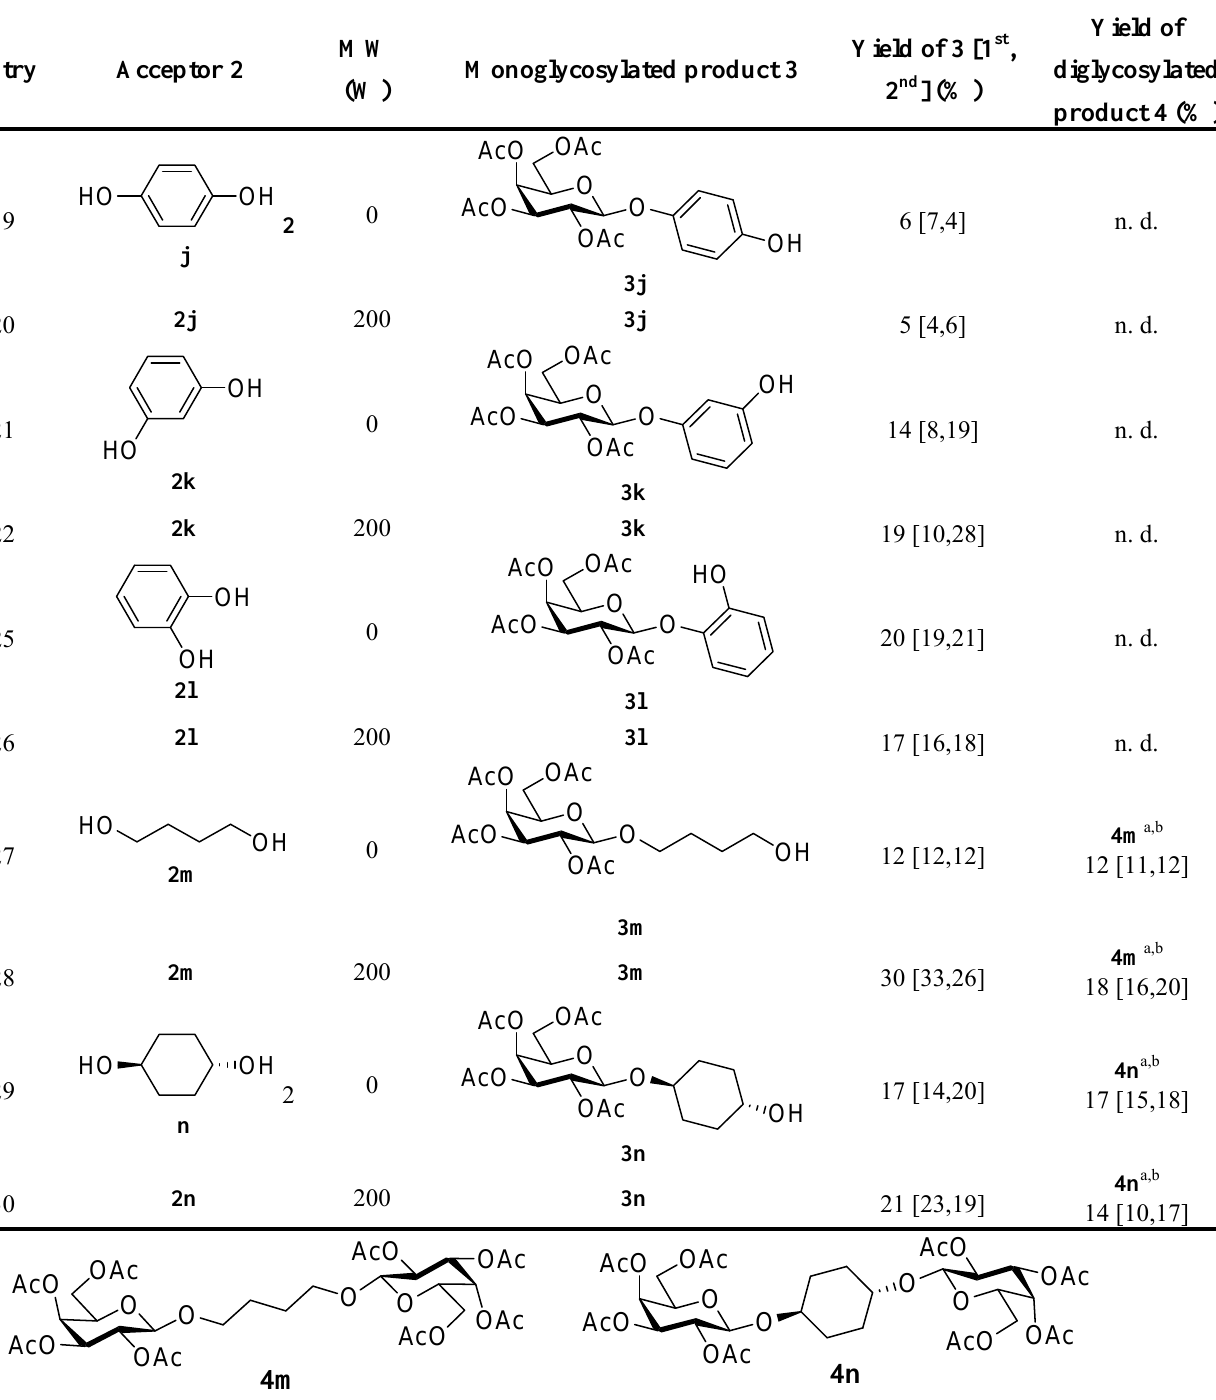
a Structure of diglycosylated product 4m and 4n . b The yields of 4m and 4n were calculated as one half molar equivalent of the glycosyl donor 1 was 100%. Table 3 indicates the result of the glycosylation reactions with diols 2j - n . Without MW irradiation, monoglycosylated products 3j [31], 3k [32], 3l [32], 3m , and 3n were isolated in 6~20% yields. Diglycosylated products were also isolated from the reaction with aliphatic diol acceptors to give